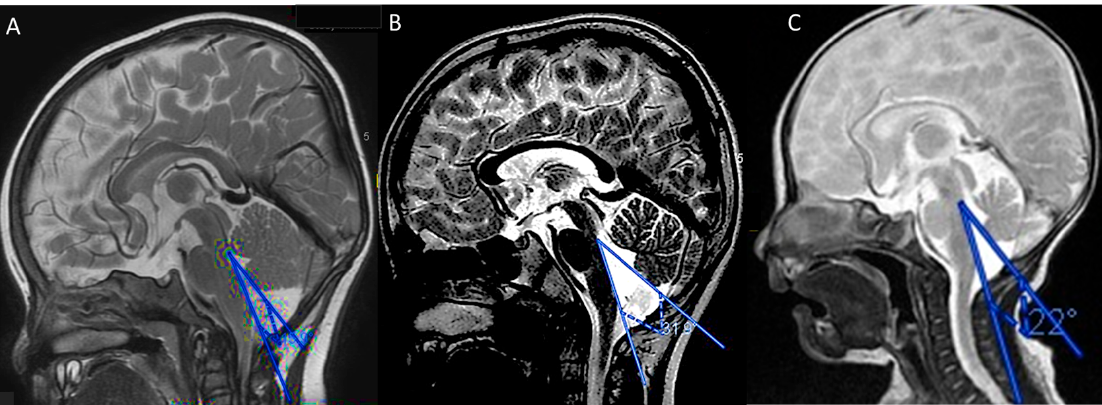
Figure 1. MRI image features (demonstrated by T2-weighted imaging). ( A ) Case 1 with mega cis- terna magna. ( B ) Case 2 with vermian hypoplasia (with a tegmento-vermian angle at 32 degrees). ( C ) Case 3 with mega cisterna magna. The tegmento-vermian angle (illustrated using blue-colored lines) is the angle between the brain stem’s dorsal side and the ventral part of the vermis. An angle of ≥ 30° indicates the presence of vermian